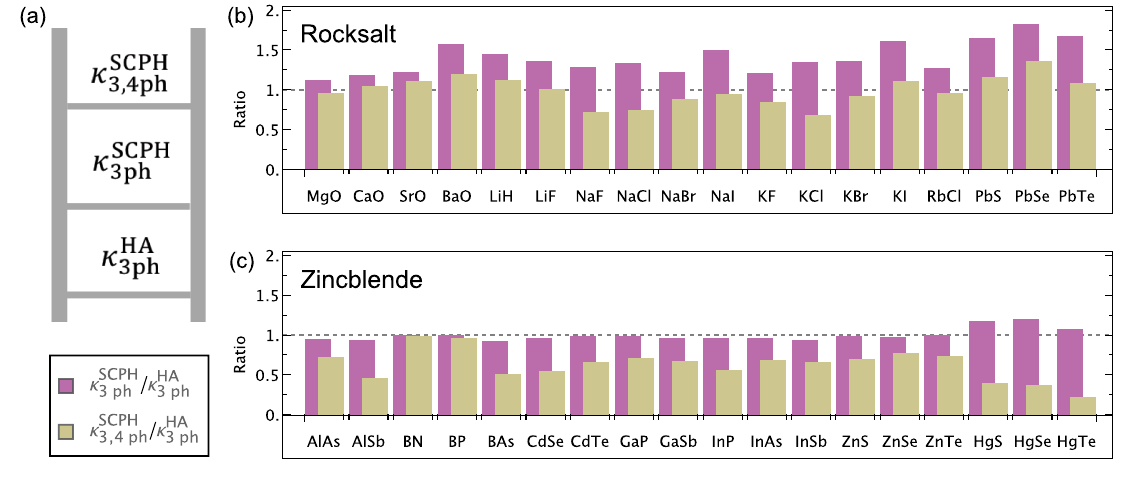
FIG. 2. Comparison of lattice thermal conductivity calculated using various levels of theories for selected binary rocksalts and zinc blendes at 300 K. (a) Schematic showing the ladder of approximations employed in computing κ based on the phonon gas model, L namely, HA þ 3 ph, SCPH þ 3 ph, and SCPH þ 3 ; 4 ph, denoting the level of theory from low to high. HA and SCPH, respectively, denote the harmonic approximation (without anharmonic renormalization) and self-consistent phonon approximation (with anharmonic renormalization from quartic anharmonicity) used for computing phonon frequencies, and 3ph and 4ph indicate three-phonon and four- phonon scattering rates, respectively. The resulting lattice thermal conductivities are denoted as κ HA 3 , κ SCPH 3 , and κ SCPH 3 , respectively. ; 4 ph ph ph = κ HA 3 = κ HA 3 (b,c) Calculated ratio of κ SCPH 3 (purple bars) and κ SCPH 3 (yellow bars), respectively. The absolute values of κ HA 3 , κ SCPH 3 , and ; 4 ph ph ph ph ph ph κ SCPH 3 ; 4 ph are listed in Table